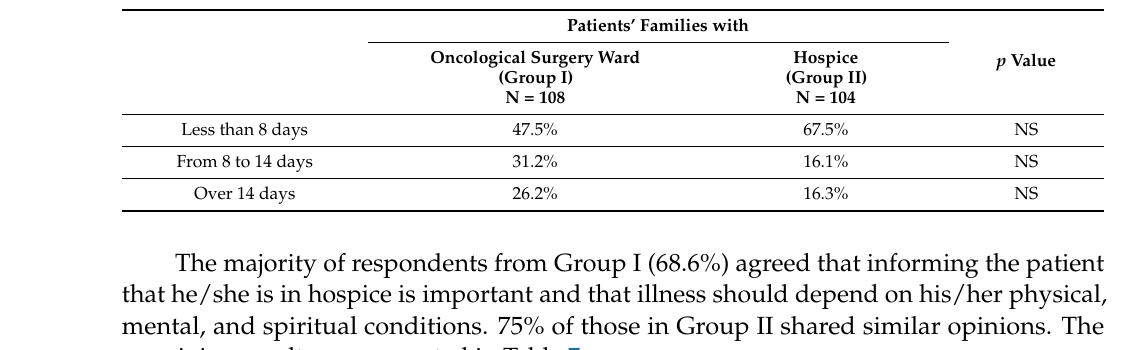
Table 6. The respondents’ opinions on the waiting time for admission to hospice.